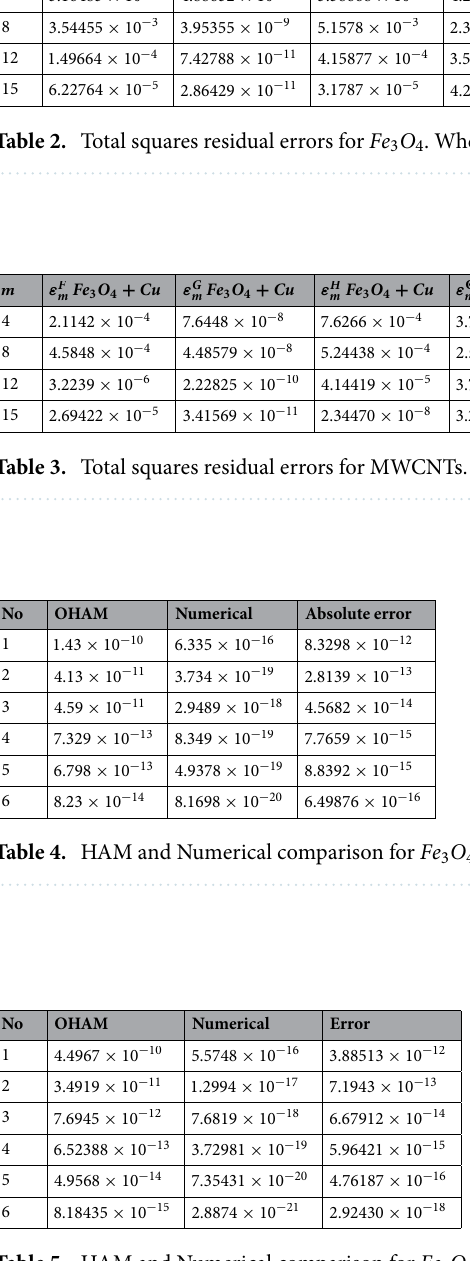
Table 5. HAM and Numerical comparison for Fe 3 O 4 + Cu : when φ Fe 3 O 4 = φ Cu = 0.02, Pr = 6.2, Re ω = 0.3, Re (cid:31) = 0.13.